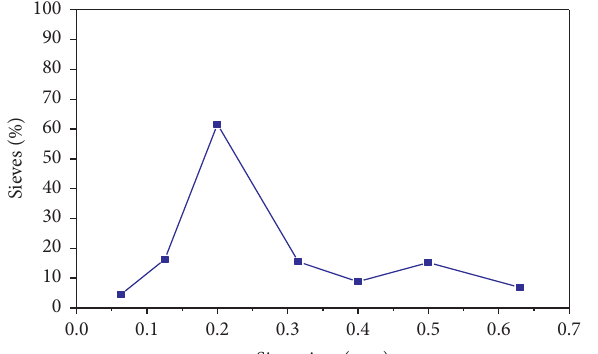
Figure 2: Granulometric curve of the sand used.